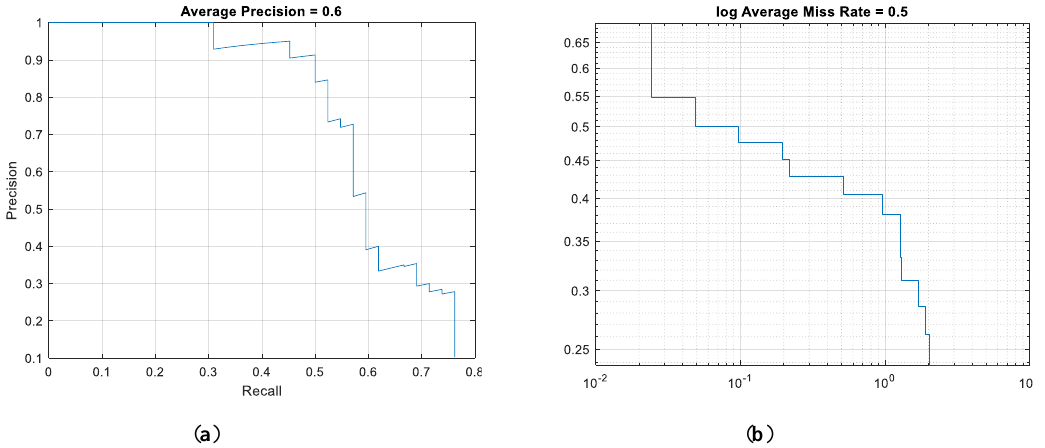
Figure 5. Model accuracy evaluation curve. ( a ) accuracy and recall curve; ( b ) error rate curve.